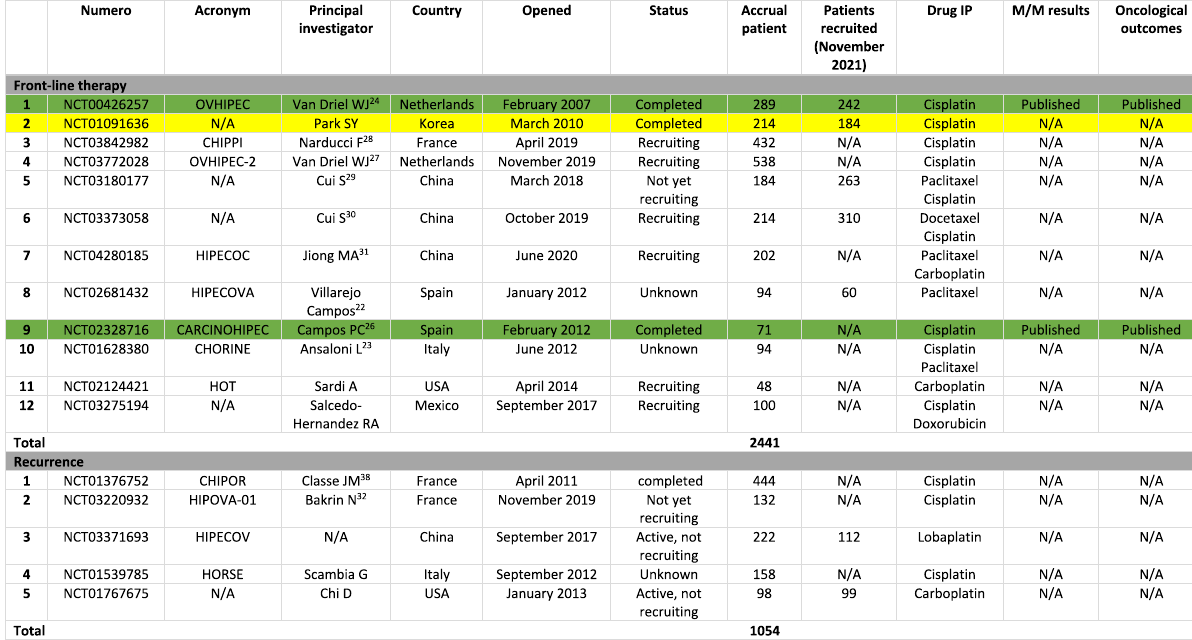
Table  : Prospective randomized trials evaluating CRS and HIPEC in ovarian